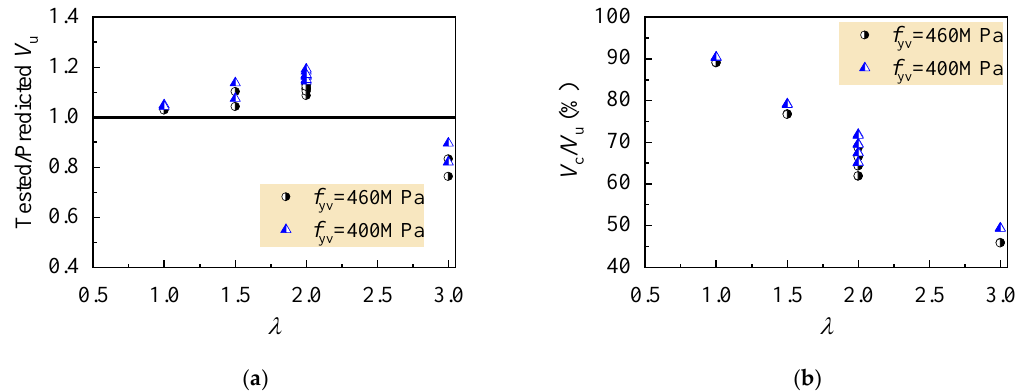
Figure 10. Statistical results of bearing capacity of test beams: ( a ) ratios of tested to predicted values; ( b ) percent of shear strength provided by CRAC.